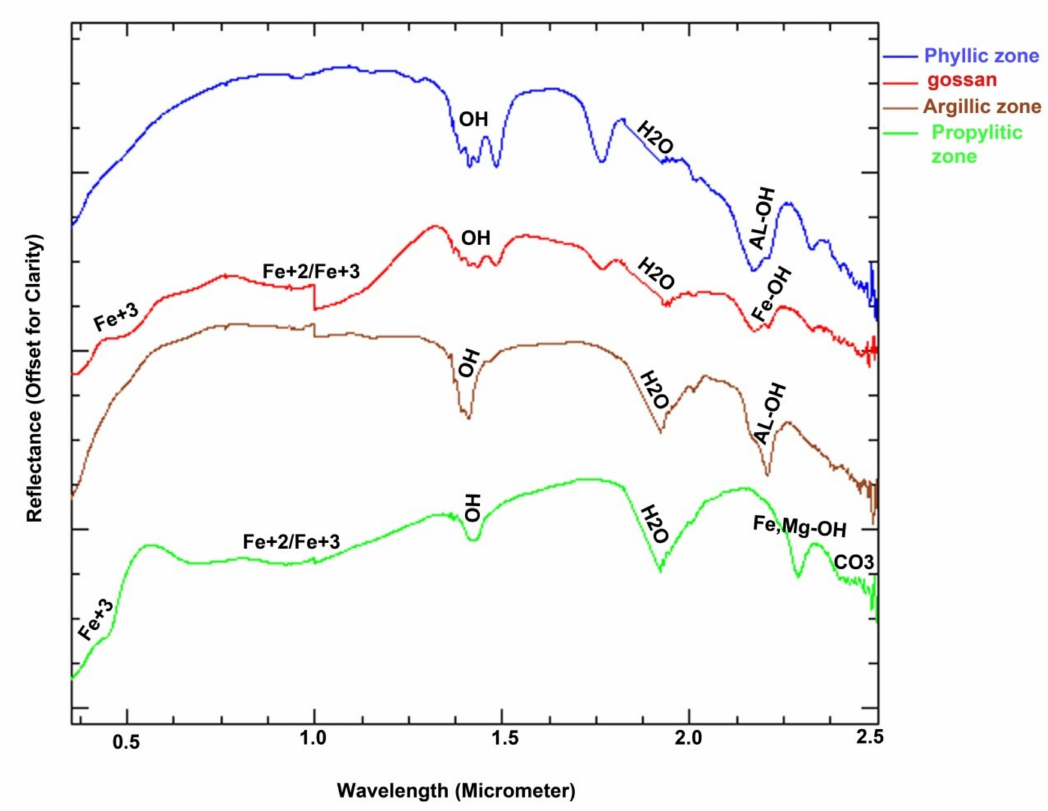
Figure 13. Laboratory reflectance spectra (average) of altered rock samples collected from phyllic, gossan, argillic, and propylitic zones. The main absorption feature spectra attributed to Fe+2, Fe+3, OH, H2O, Fe-OH, Al-OH, Fe, Mg-OH, and CO3 are annotated. A sensor-shift could be seen around 1.0 µ m especially for gossan and argillic